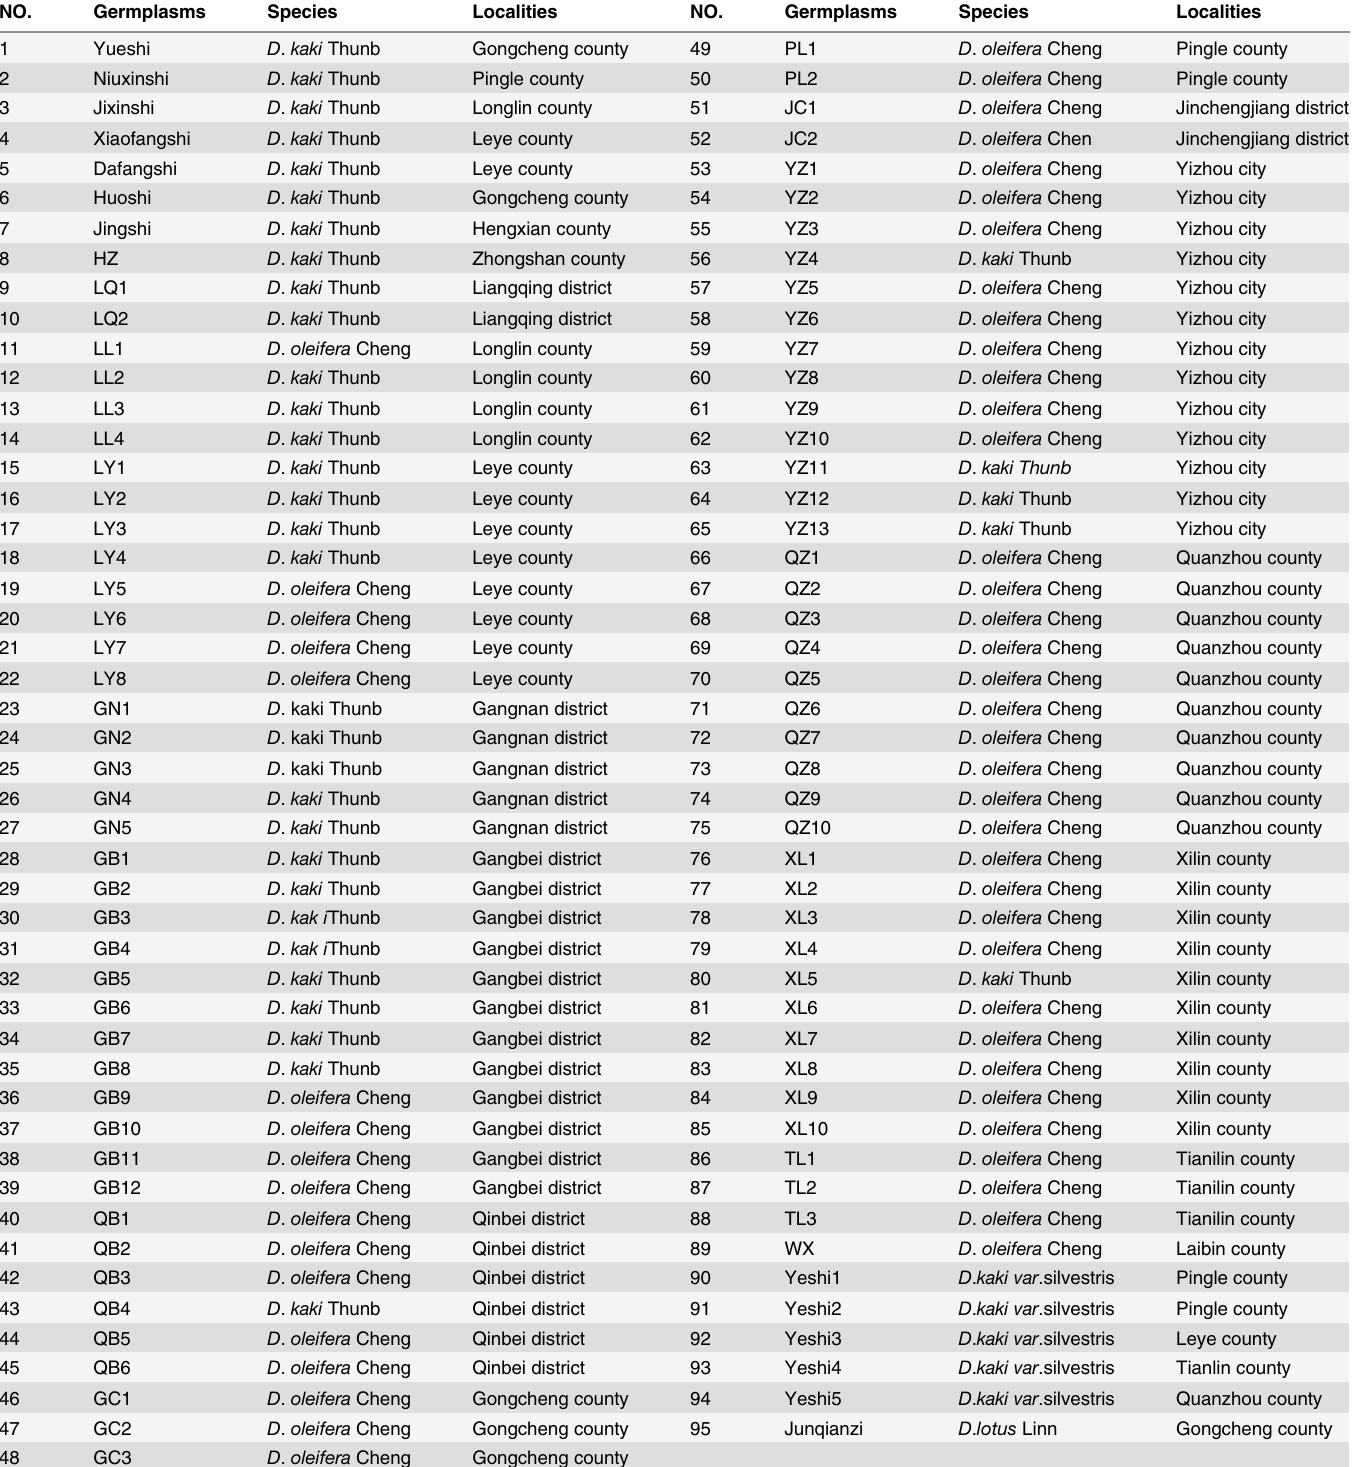
Table 1. Diospyros germplasm resources and their respective localities.